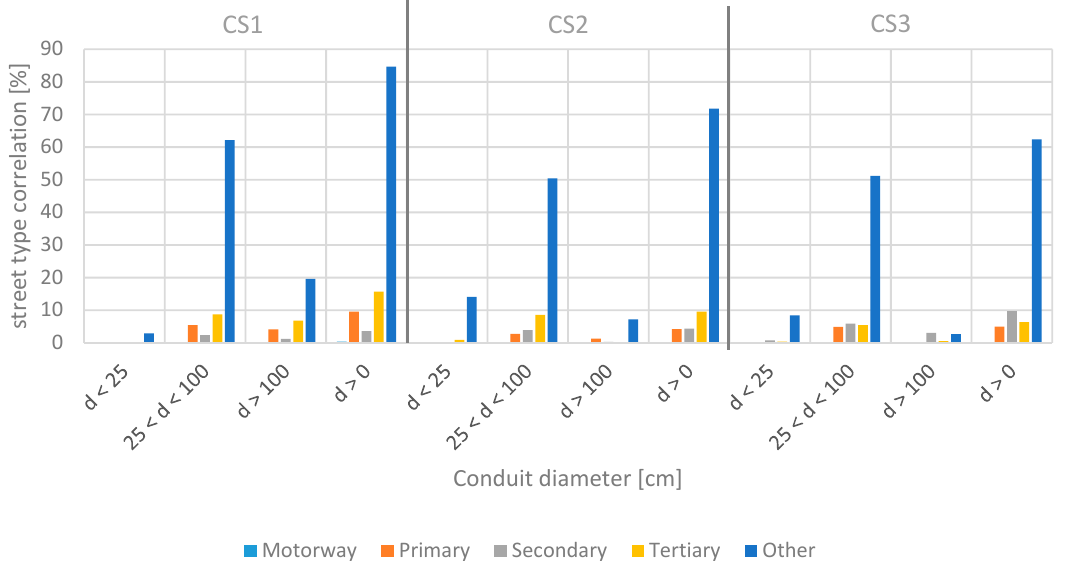
Figure 7. Conduit diameter in correlation with street types.